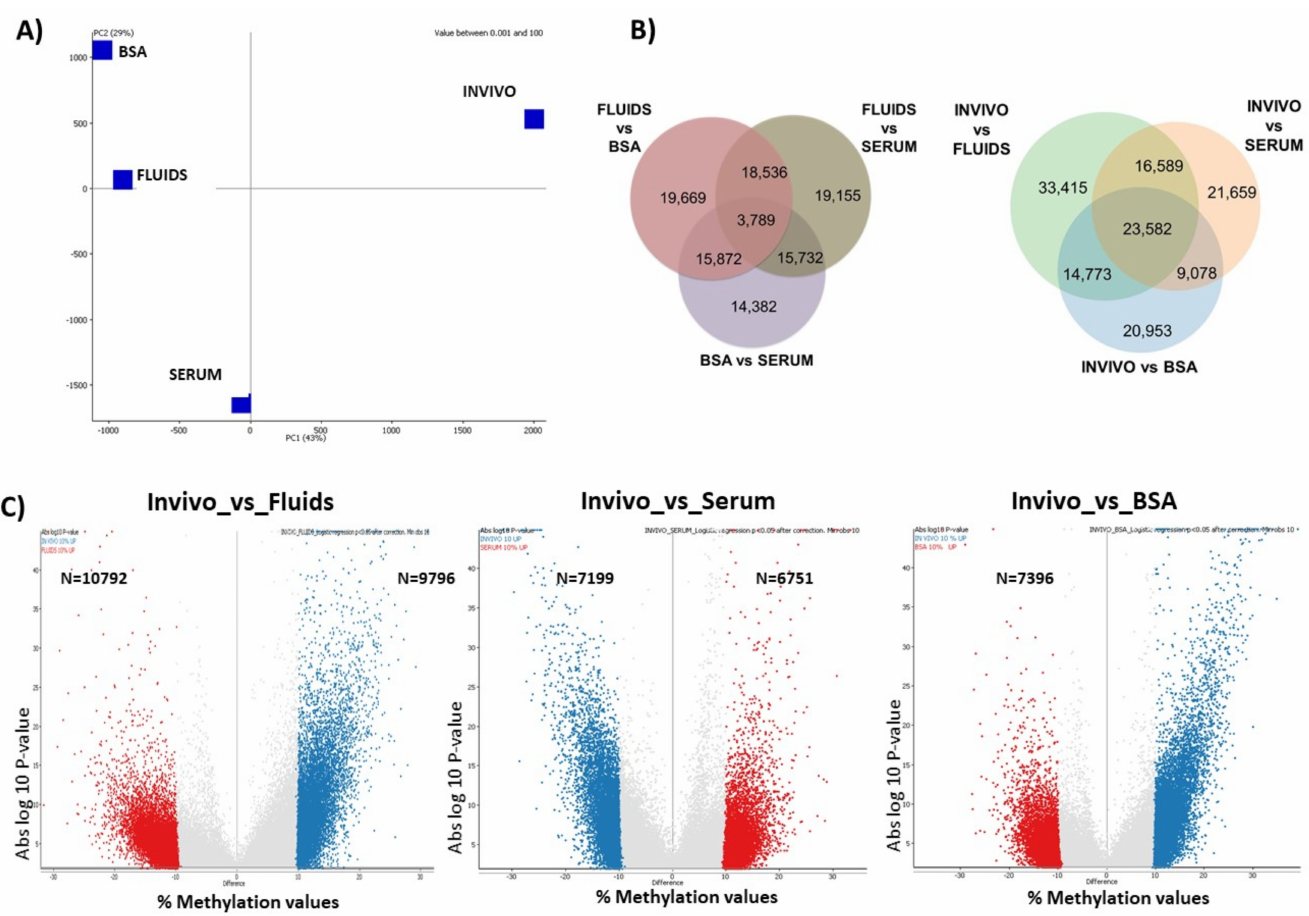
Figure 2. ( A ) Principal component analysis. ( B ) Venn diagrams show shared DMTs between pair-wise comparison. ( C ) Volcano plots show absolute log p -value vs. % methylation values differences for INVIVO blastocyst vs. FLUIDS, SERUM or BSA. Table 1. Differentially methylated regions (tiles 100 CpGs) by logistic regression ( p < 0.05) in each pair-wise comparison. From these tiles, DMTs with more than 10% methylation values differences were